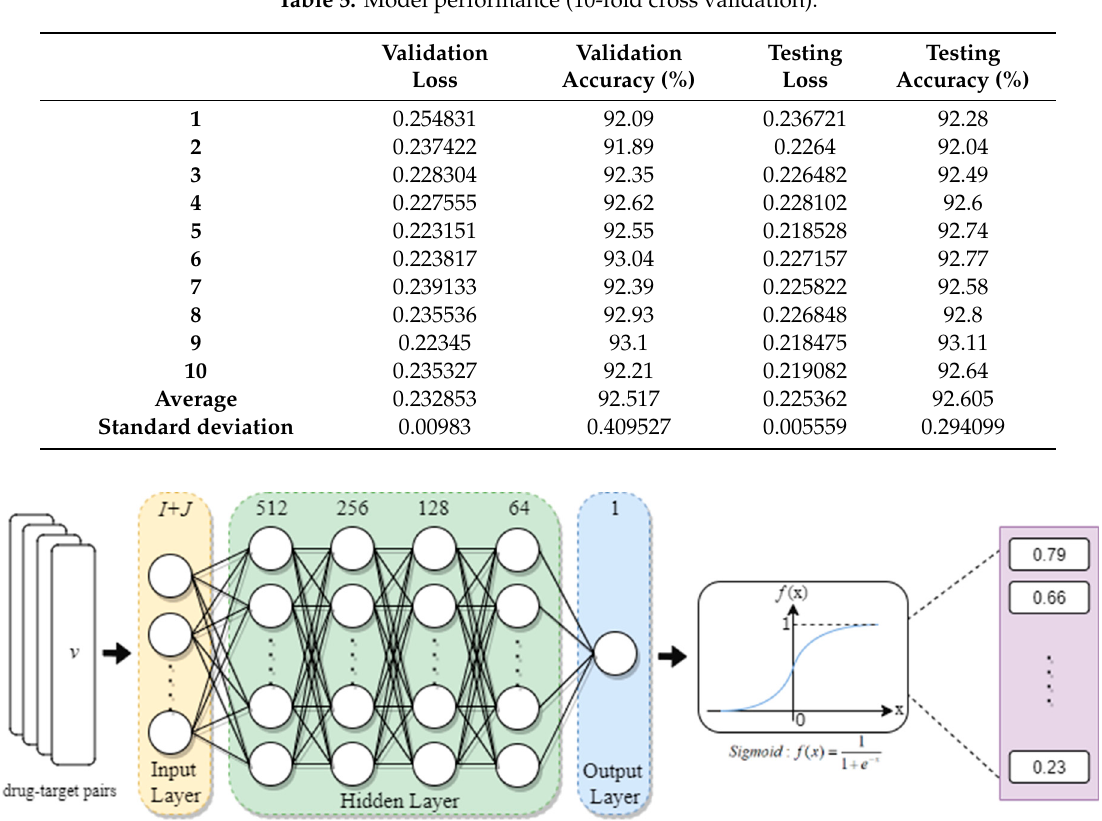
Figure 6. Configuration of the deep learning-based DTI model. v is the vector of each drug-target pair for the input layer; I is the total number of drug features; and J is the total number of target features.